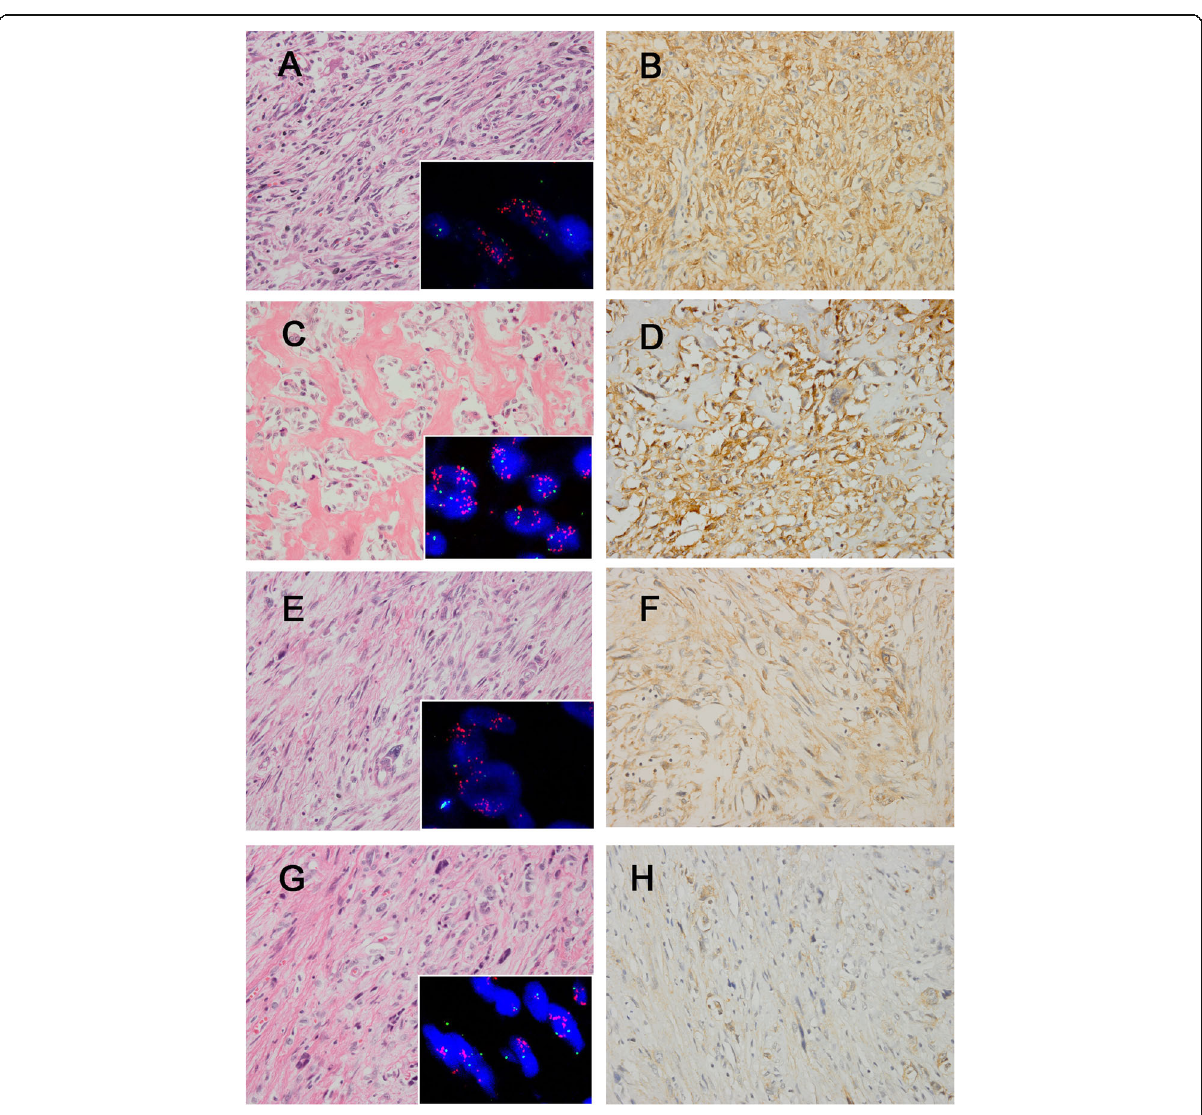
Fig. 2 The histologic features of DDLs and corresponding FRS2 FISH and FRS2 immunostaining results. DDL with fibrosarcoma-like differentiation( a ), showing FRS2 amplification ( inset ), displayed 3+ FRS2 immunostaining, exhibiting diffuse and strong cytoplasmic FRS2 expression ( b ). DDL showing osteosarcoma-like differentiation( c ), with FRS2 amplification ( inset ), had 3+ FRS2 staining, harboring strong FRS2 immunostaining ( d ). DDL demonstrating undifferentiated sarcoma-like differentiation( e ), with FRS2 amplification ( inset ), harbored 2+ FRS2 staining ( f ). DDL with leiomyosarcoma-like differentiation( g) harboring FRS2 amplification ( inset ) showed 1+ positivity for FRS2 immunostaining ( h ). Red signals represent FRS2 . Green signals represent chromosome12 centromeres. (a, c, e, g, haematoxylin and eosin; b, d, f, h, immunostaining) (original magnification a-h ×